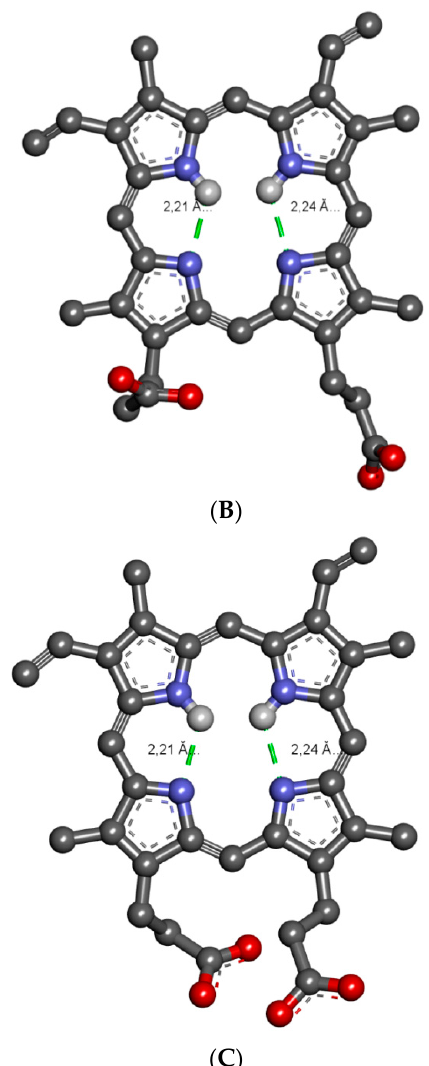
Figure 12. The differences in molecular conformations of PpIX before and after computational simulation. ( A ) Initial conformation of PpIX; ( B ) conformation of PpIX bound in the hemin site; ( C ) conformation of PpIX bound in Sudlow’s Site 1. Molecules are shown in the ball and stick representation of their aromatic forms. Intramolecular hydrogen bonds are highlighted with dashed lines (1 Å = 0.1 nm). For the sake of clarity, only polar hydrogen atoms are displayed.